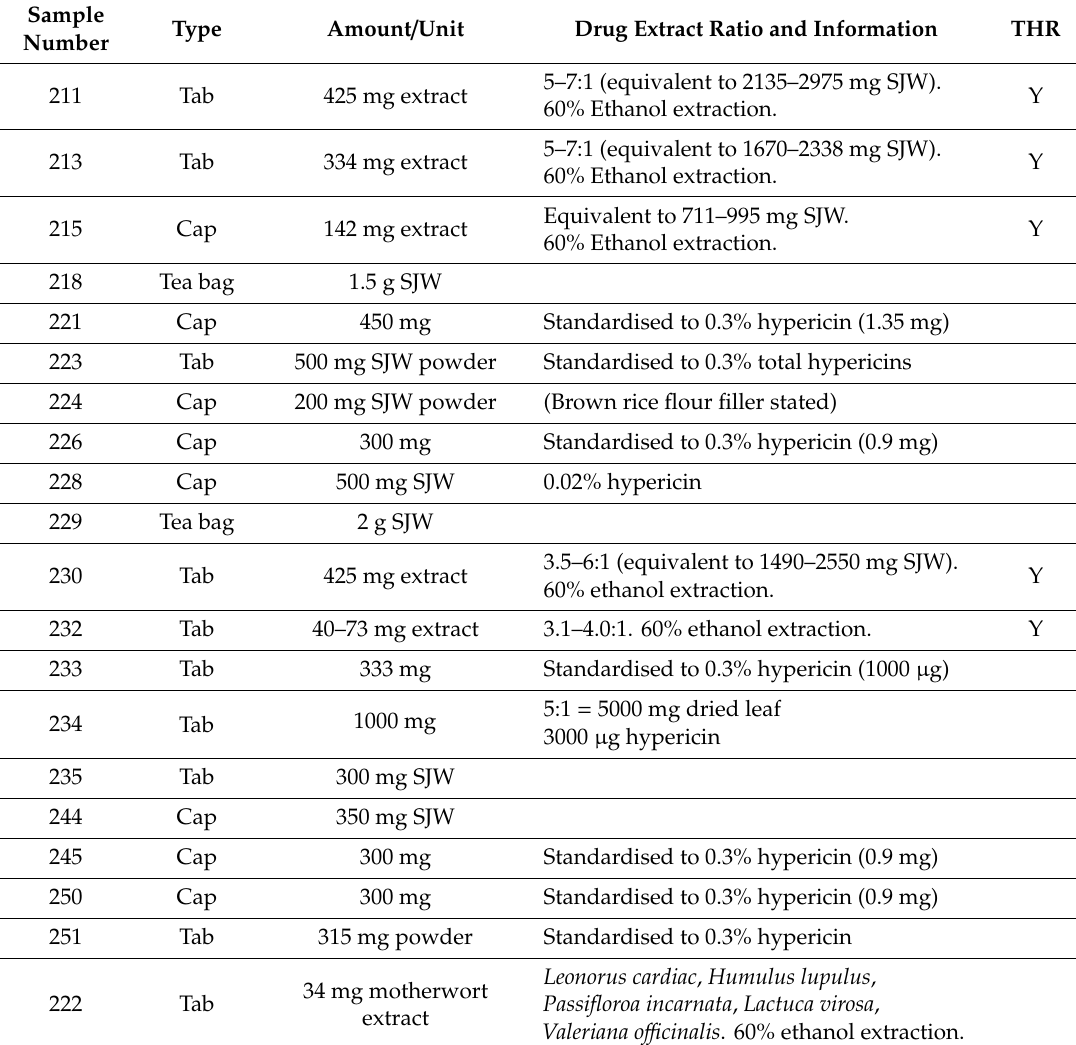
Table 1. Sample information and amount of material used in DNA